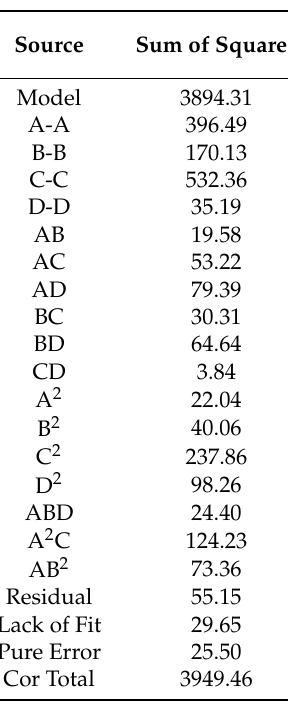
Table 7. ANOVA for the reduced cubic model.